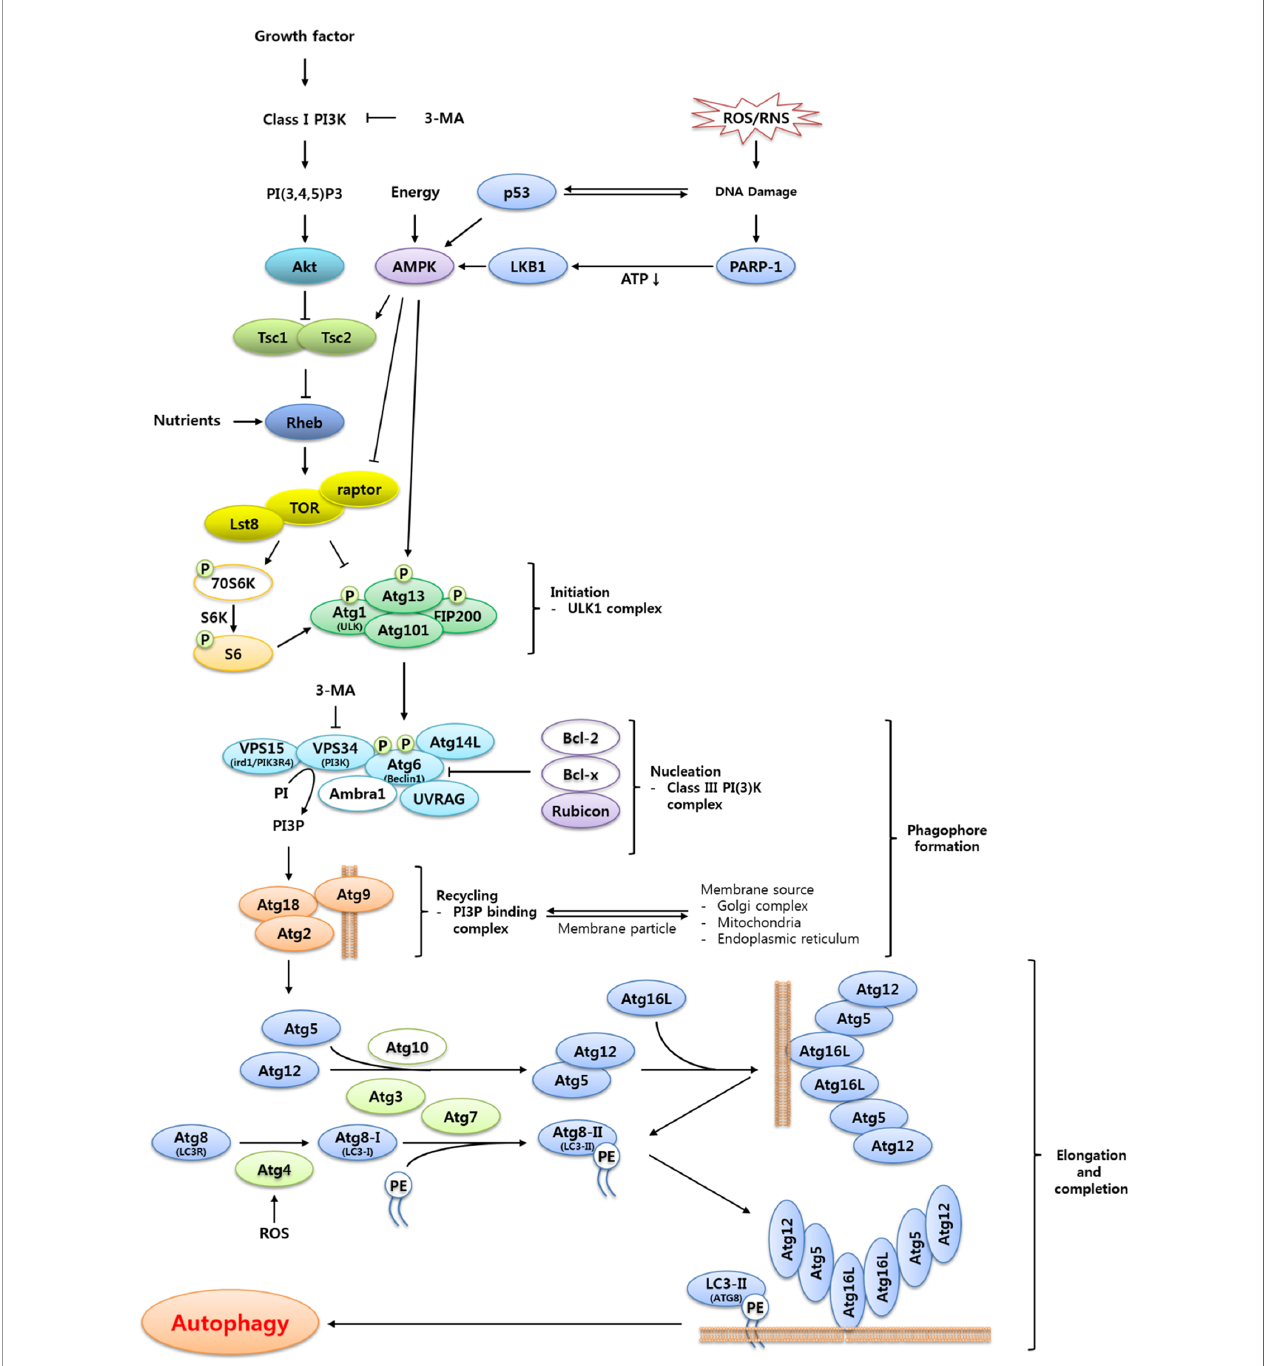
FIGURE 2 | Proposed signaling cascade triggering TOR-regulated autophagy in T. molitor. Most of the autophagy-related genes included in the scheme were identi fi ed in the T. molitor RNA-Seq and EST databases. Growth factors such as the insulin receptor and nutrient-rich conditions negatively regulate autophagy, while reactive oxygen/nitrogen species (ROS/RNS), DNA damage and a low cellular energy status (that is, a high AMP/ATP ratio) induce autophagy. Upon generation of autophagy signals by the appropriate stimuli, an initiation complex comprising Atg1, Atg13, Atg101 and Fip200 is formed. Subsequently, the nucleation complex consists of the Vps15-Vps34-Atg6-Atg14-UVRAG complex, alternatively named Class III PI (3)K complex. In addition, the Atg2-Atg18 complex supports the delivery of the membrane particles from the Golgi, mitochondria or endoplasmic reticulum. Vesicle elongation is carried out by two ubiquitin-like complexes: the Atg5-Atg12: Atg16 complex, generated through the E1- and E2-like enzymatic activity of Atg7 and Atg10, respectively; and the Atg8-PE complex, generated by the proteolytic activity of Atg4 before transfer of Atg8 to the E1- and E2-like enzymes Atg7 and Atg3, respectively. Open circles show either non-Atg components (3-MA, PI3P, Class I PI3K, PI(3,4,5)P3 and PE) or autophagy related genes (70S6K, Bcl-2, Bcl-x, Ambra1 and Atg10) unidenti fi ed in T. molitor